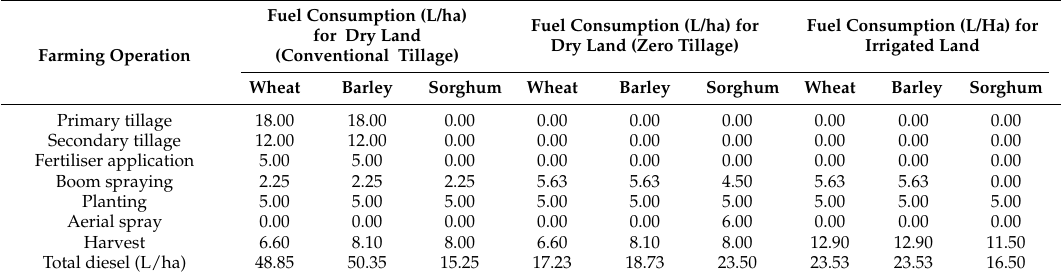
Table 6. Fuel (diesel, L/ha) consumption (except irrigation fuel) for three high value grain crops in Southern Grain Region (From Victoria).